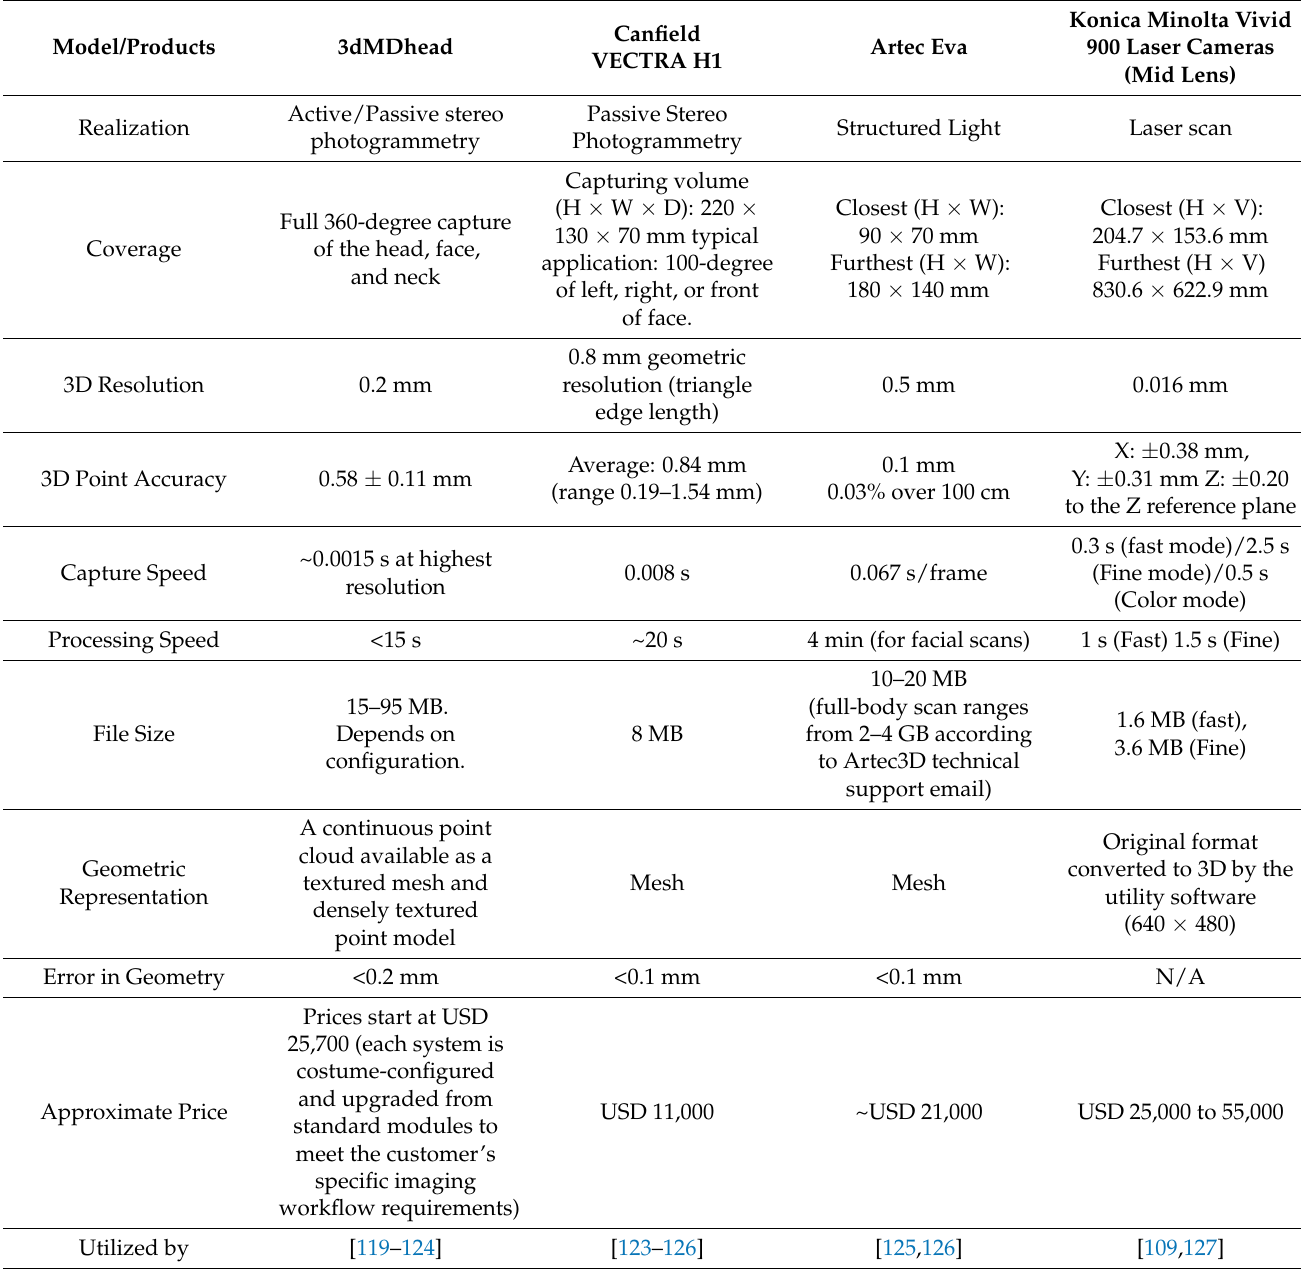
Table 1. A comparison between four scanning tools using three different 3D scanning techniques: 3dMDhead, Canfield VECTRA H1, Artec Eva, and Vivid 900